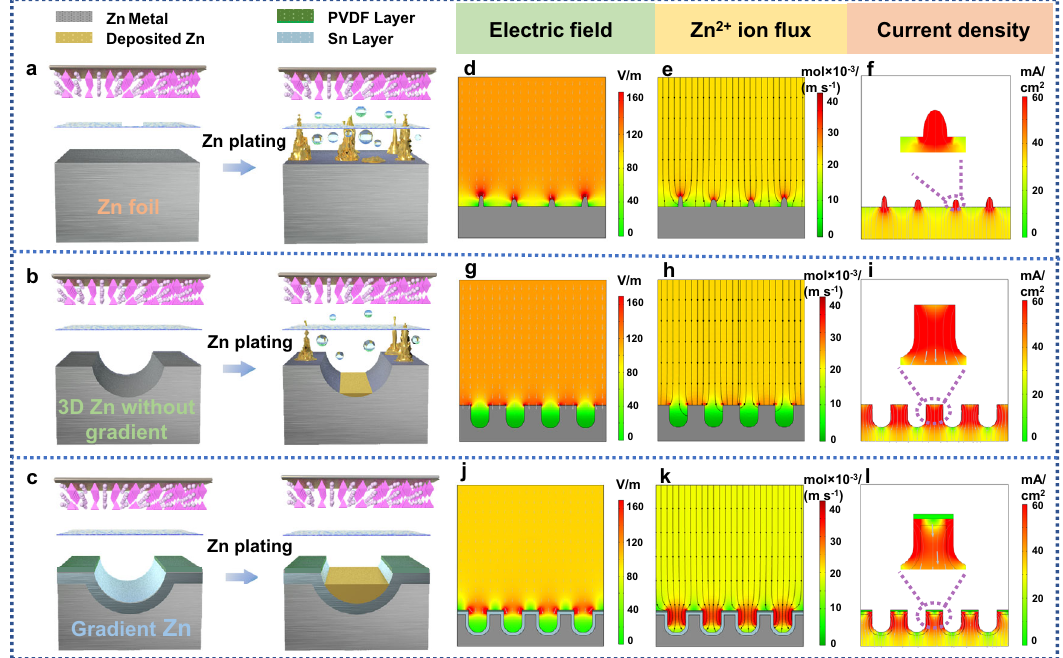
Fig. 1 | Zn deposition behavior and the fi nite element simulations of three different electrodes (bare Zn, 3D Zn without gradient, and gradient Zn). The modelof a Znfoil, b 3D Znwithout gradient, and c gradient Zn electrodes afterZn